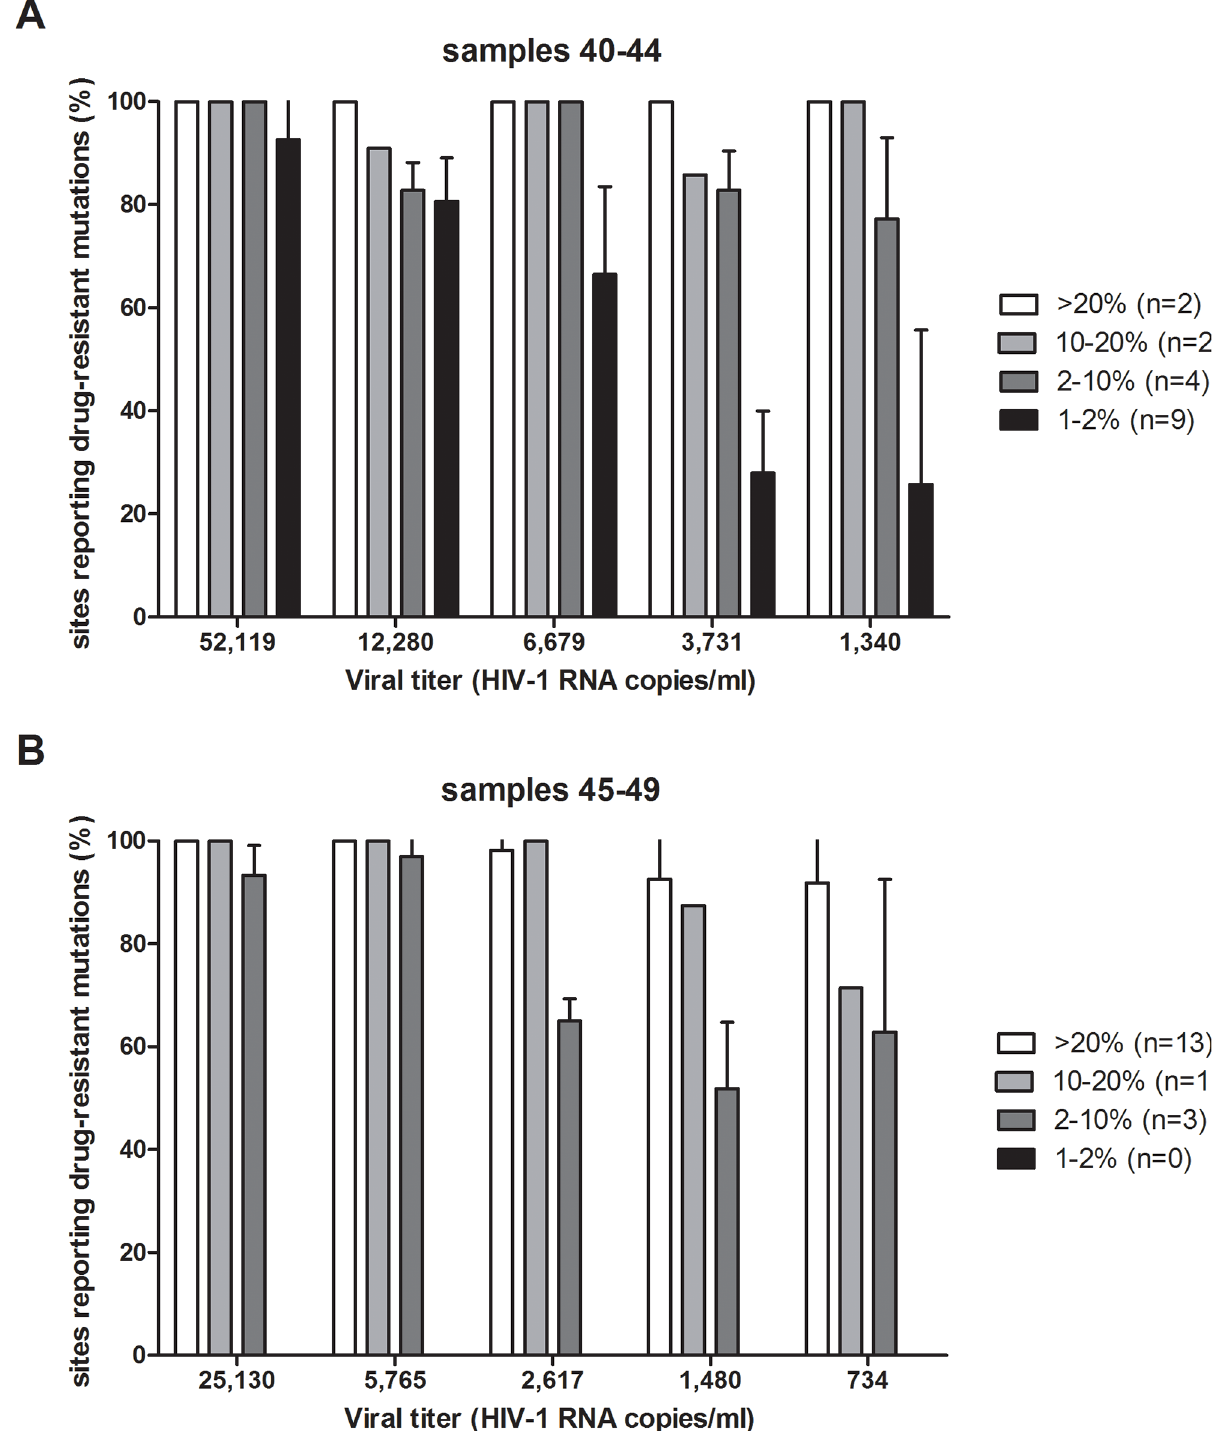
Fig 2. Drug resistance mutation detection in limiting dilution series. Two HIV-1 subtype B samples were used for the dilution series (A, samples 40 – 44; B, samples 45 – 49). The four groups shown in the histogram are based on the median frequency of each drug resistance mutation in its respective undiluted sample: > 20% (white bars), 10 – 20% (bright grey bars), 2 – 10% (dark grey bars), and 1 – 2% (black bars). The means and standard deviations are given of the percentage of sites reporting drug-resistance mutations in these categories. The number of mutations in each category is represented by n.